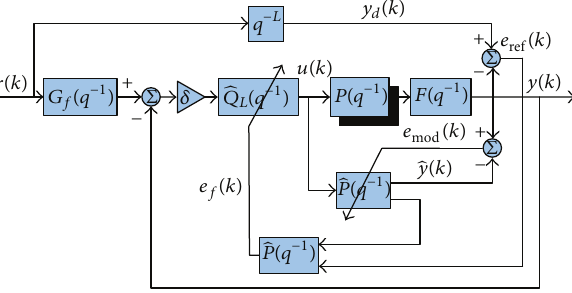
Figure 2: Closed loop direct adaptive inverse